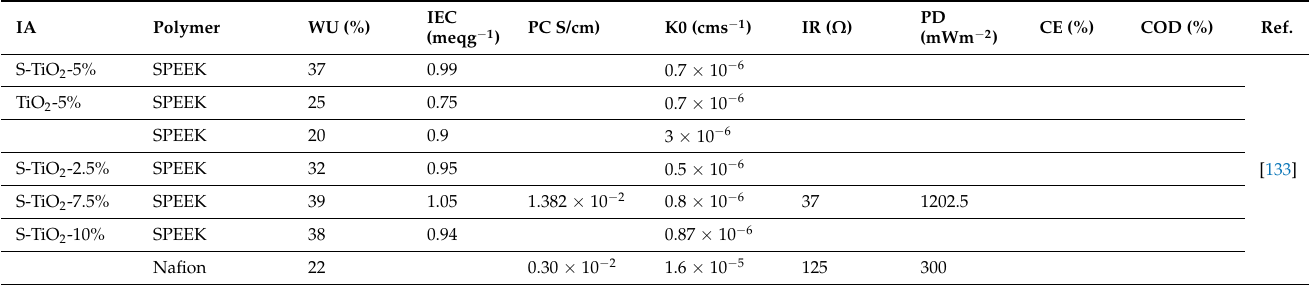
Table 2. Physicochemical properties and performance evaluation results of sulfonated TiO 2 containing polymer membrane for MFC